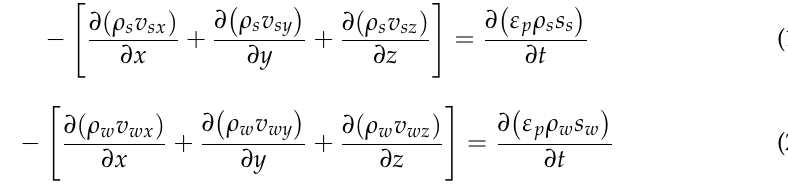
where ρ s is the slurry density, kg/m 3 ; s s is the volume fraction of slurry in the medium; ρ w is the density of water, kg/m 3 ; t is the grouting time; v is the seepage field velocity, m/s; vs. is the slurry flow velocity, m/s; v w is the water flow velocity, m/s; s w is the volume fraction of water in the medium; μ is the fluid viscosity, Pa·s; K is the permeability of the medium, m 2 ; ε p is the porosity of the medium; c w is the mass fraction of water in the medium; p is the slurry pressure, MPa; and D c is the capillary diffusion coefficient, m 2 /s. Equations (3)–(5) are dynamic equations, also known as the generalised Darcy’s law, and the control equation is Equation (6).